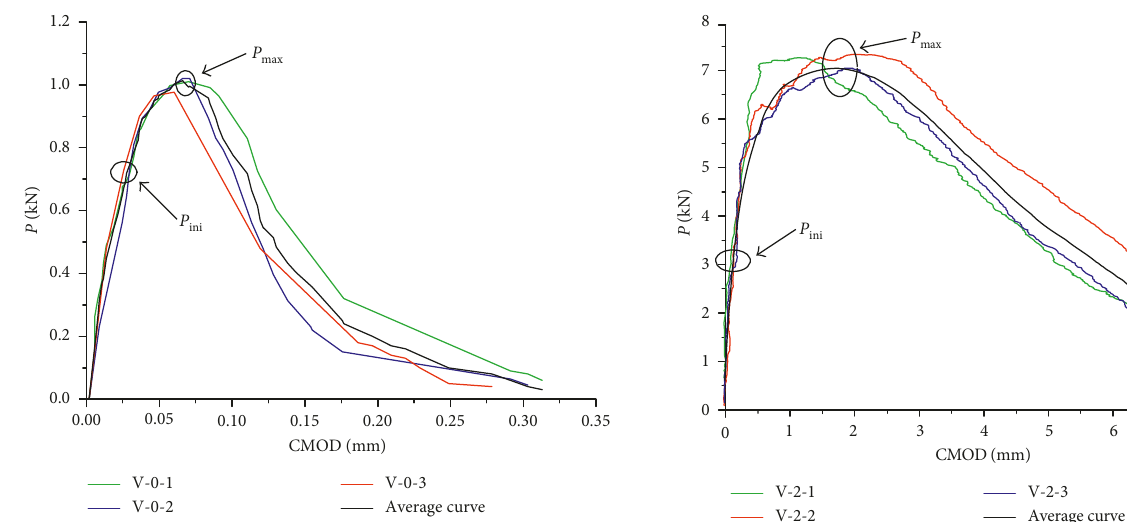
4: ECC of P -CMOD curves under static load.